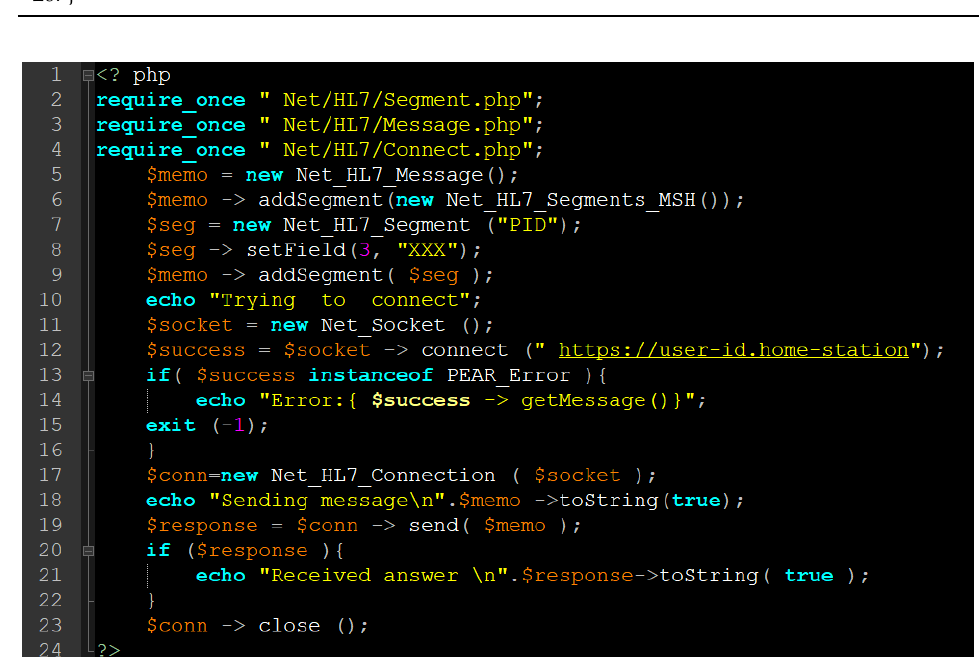
Figure 7. Interaction with HL7